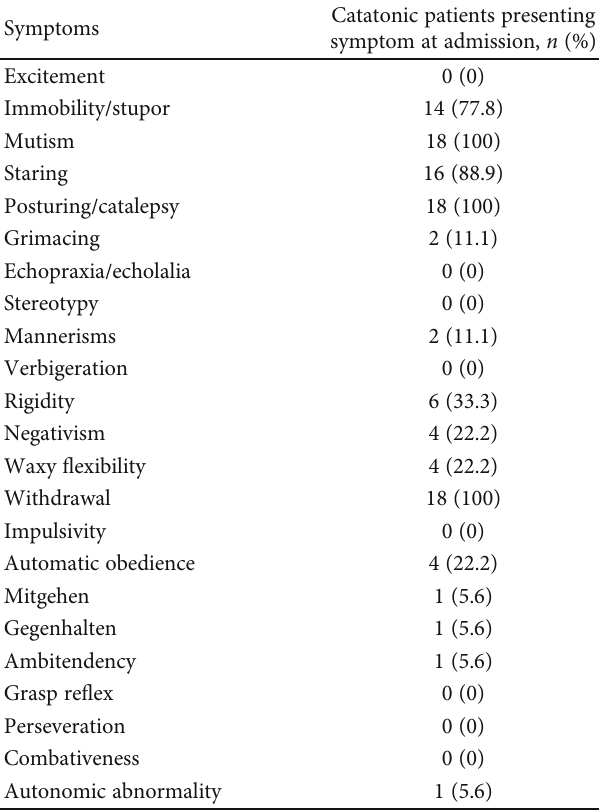
Table 2: Presence of symptoms on the Bush-Francis Catatonia Rating Scale in patients ( N = 18 ) admitted to the psychiatric unit at Jimma University Medical